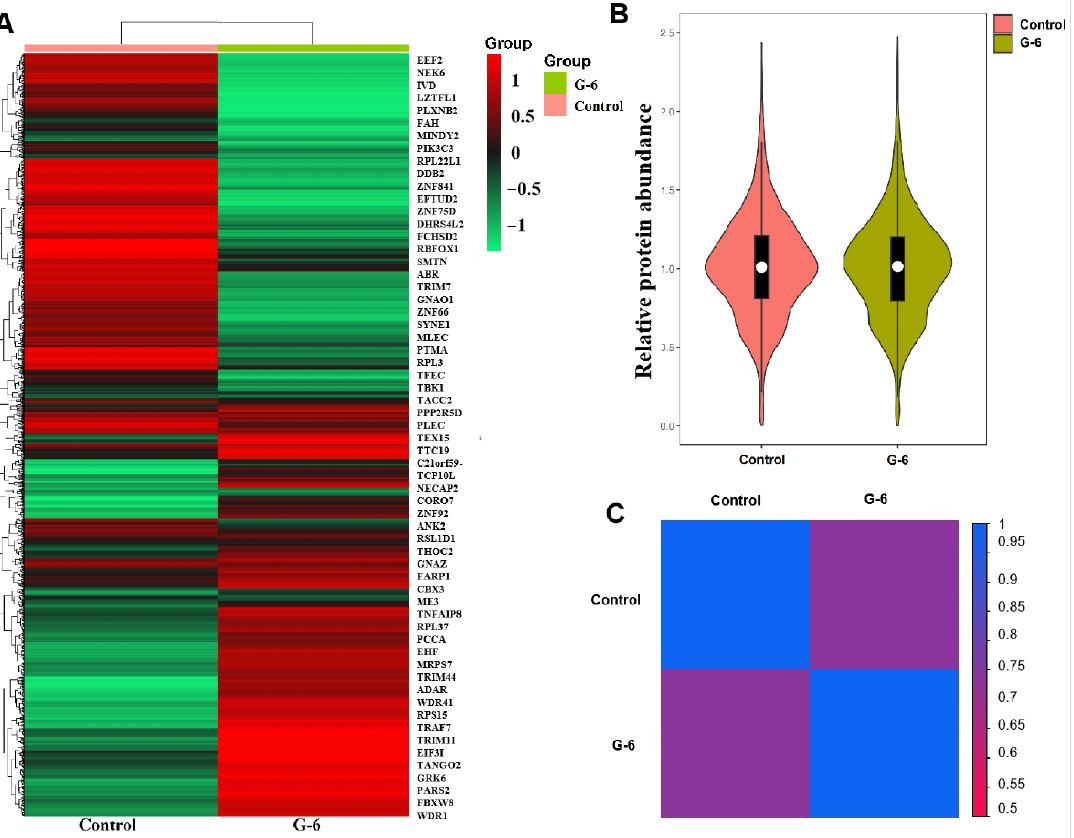
Figure 4. Quantitative analysis of protein of SW1990 cell treated with G-6 10 µM for 24 h or without. ( A ) Heatmap of the expression levels of total proteins in SW1990 cells. The red-colored clusters represent up-regulated proteins, and the green-colored clusters represent down-regulated proteins. ( B ) A violin plot showing the distribution pattern of relative protein abundance was similar and sample pre-treatment was stable. ( C ) Correlation analysis of samples (relativity weakened with color from blue to red).